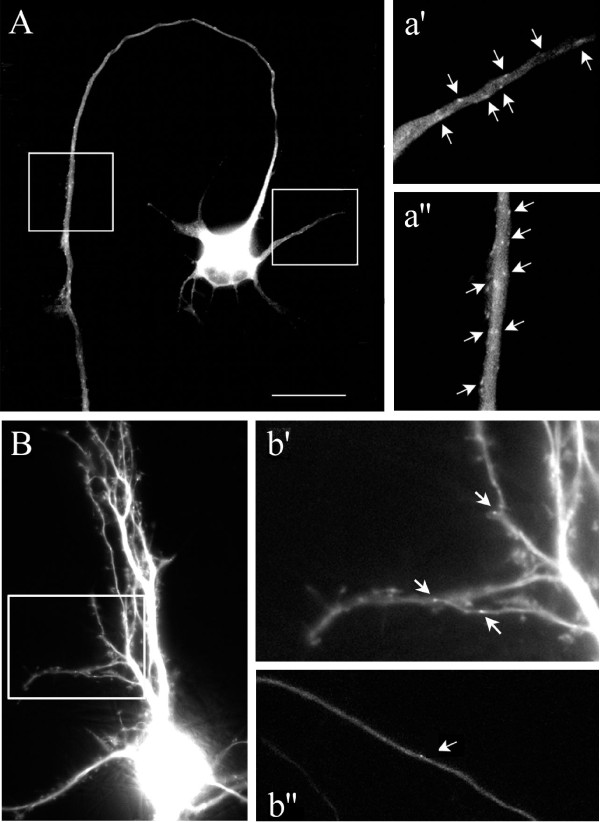
EB1-GFP dynamics. (A-b") Time-lapse imaging of EB1-GFP dynamics revealed diffuse low-level fluorescence and bright punctate comets (arrows) distributed throughout the axons and dendrites of hippocampal neurons developing in vitro. Representative still frames from movies, with higher magnification views of the boxed areas, of neurons at 1 DIV (A) (dendrite (a') and axon (a")) and 15 DIV (B) (dendrite (b') and axon (b")). Scale bar: 15 μm (A, B). See also accompanying Additional files 2 (1 DIV dendrite), 3 (1 DIV axon shaft), 4 (15 DIV dendritic arbor), 5 (15 DIV axon midshaft), and 6 (15 DIV distal axon and growth cone, not shown in figure).